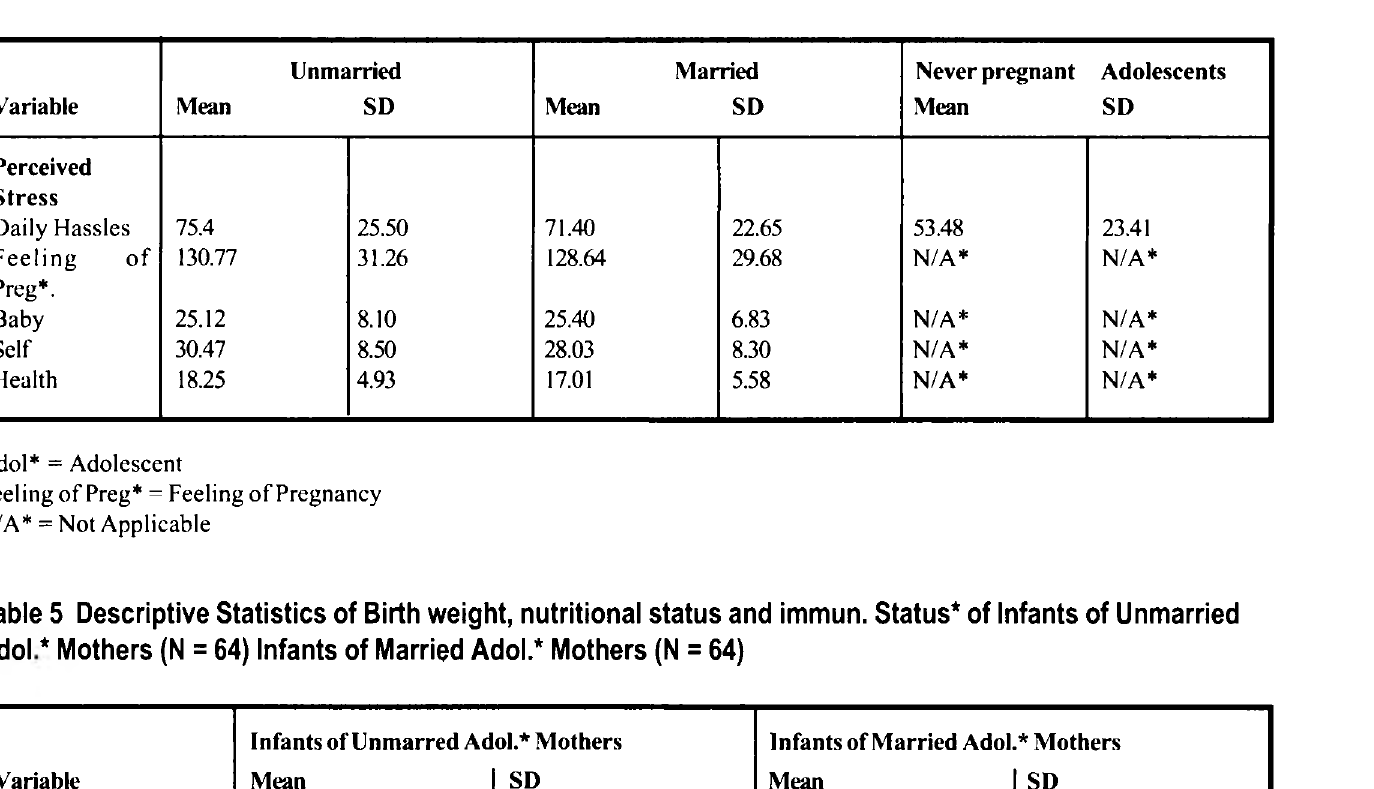
Table 5 Descriptive Statistics of Birth weight, nutritional status and immun. Status* of Infants of